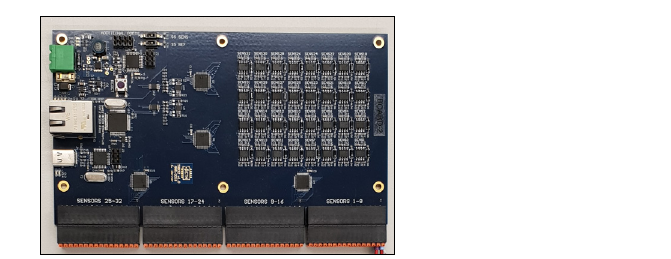
Figure 5. Power distribution and PLC evaluation setups.